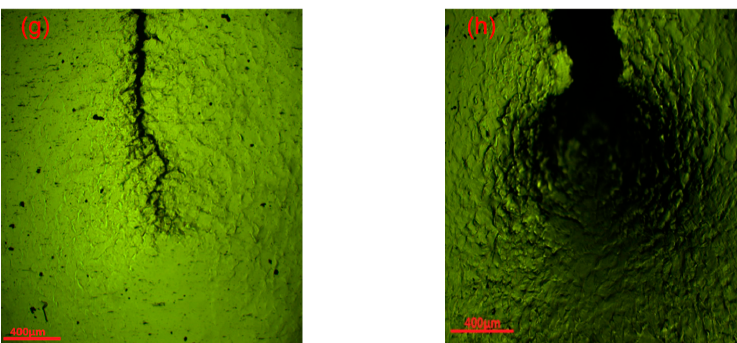
Figure 6. The morphology of specimen surface at different fatigue cycles: ( a ) 0 cycles; ( b ) 1 cycle; ( c ) 300 cycles; ( d ) 1000 cycles; ( e ) 7000 cycles; ( f ) 9000 cycles; ( g ) 17,000 cycles; and ( h ) 23,000 cycles.